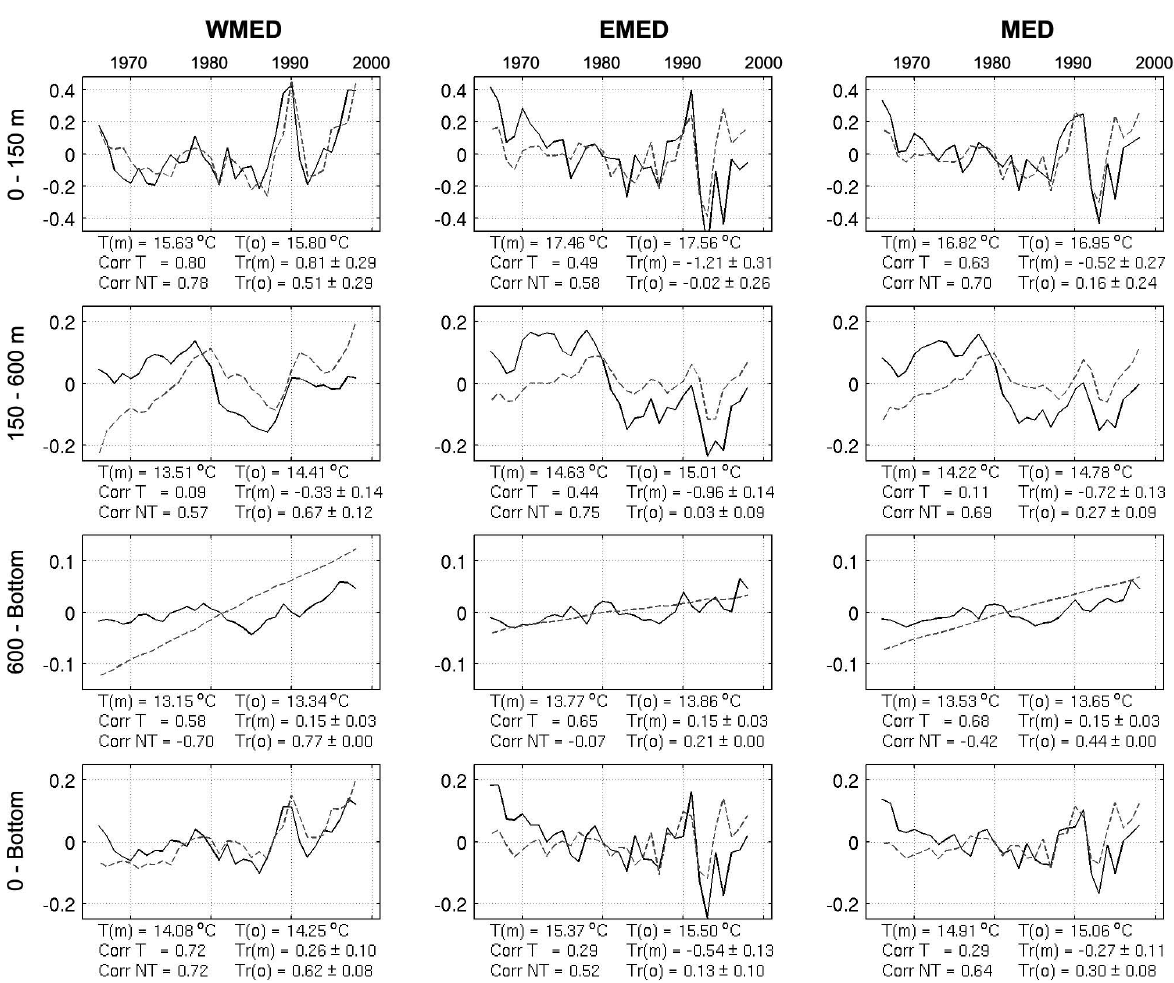
Fig . 2. – ORCA (o) (dashed-line) and MEDAR (m) (solid-line) temperature time-series divided into basins and layers (1965-1998). T refers to the mean temperature. Corr T refers to the correlation of the time-series with their respective trends. Corr NT refers to the de-trended correlation values. Tr refers to the trend